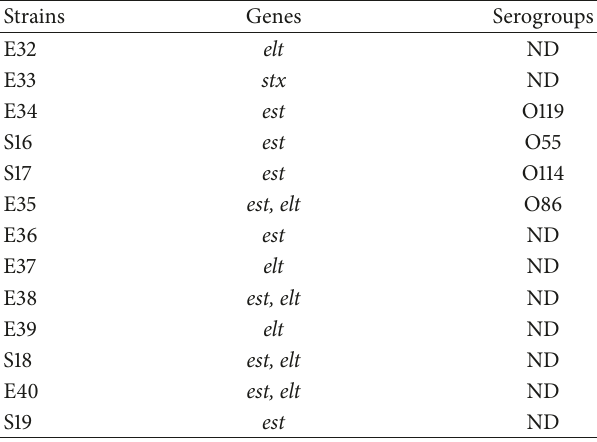
Table 6: Relationship between virulence genes and O